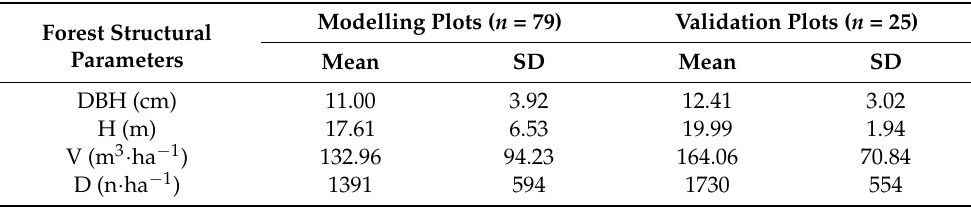
Table 1. Summary of forest structural parameters that divided into modeling and validation plots. Modelling Plots ( n = 79) Validation Plots ( n = Forest Structural Parameters